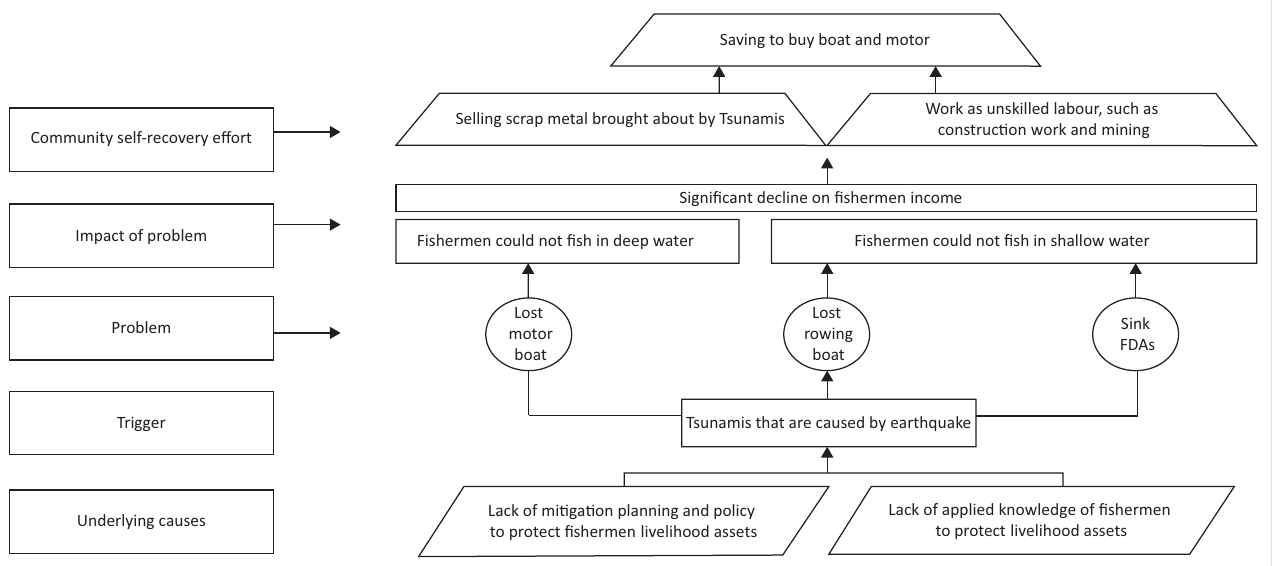
FIG URE 1: Problem tree mapping of Loli Dondo village